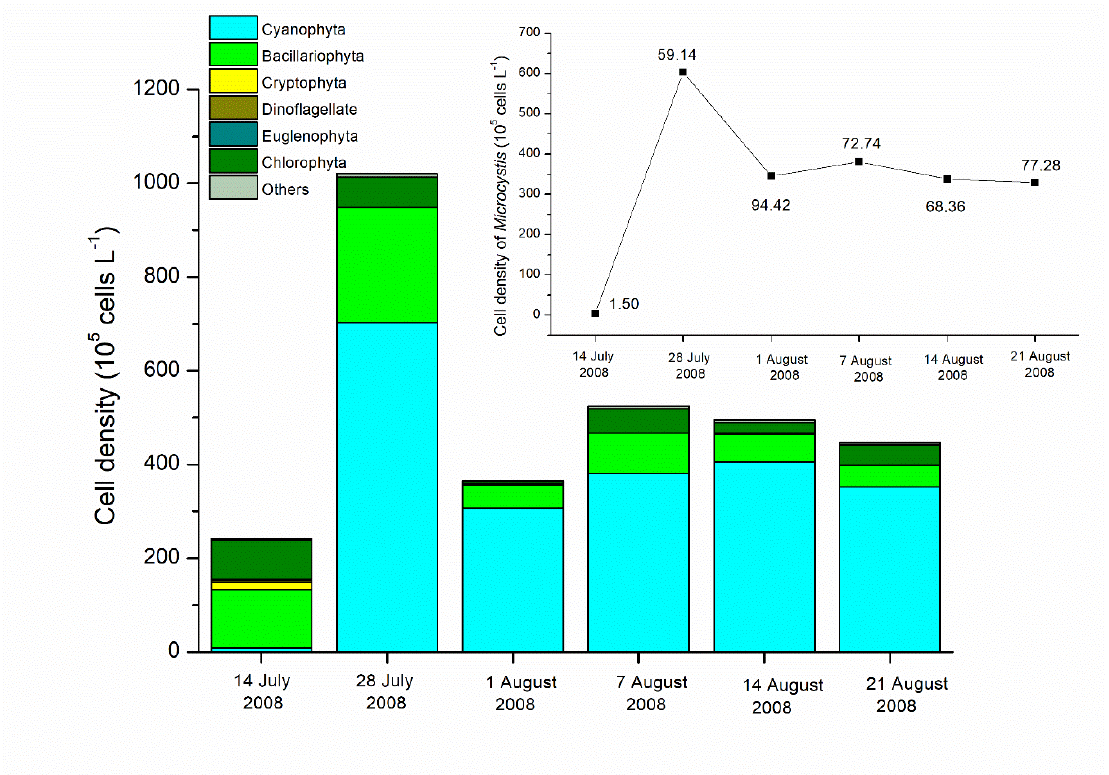
Figure 7. Phytoplankton composition and cell densities in Lake Yuehu during the study period. Numbers besides the dots in the figure indicate the percentages of the cell density of Microcystis to total phytoplankton (%).